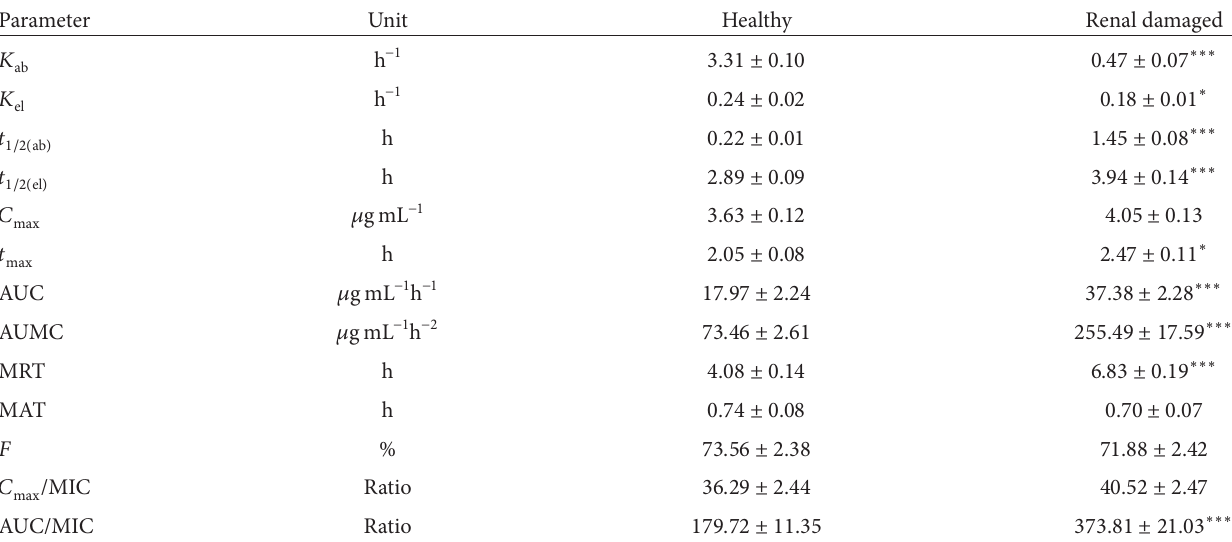
Table 2: Pharmacokinetic parameters of levofloxacin in healthy and renal damaged ducks after a single PO administration of 10 mgkg − 1 bwt ( 𝑛 = 6